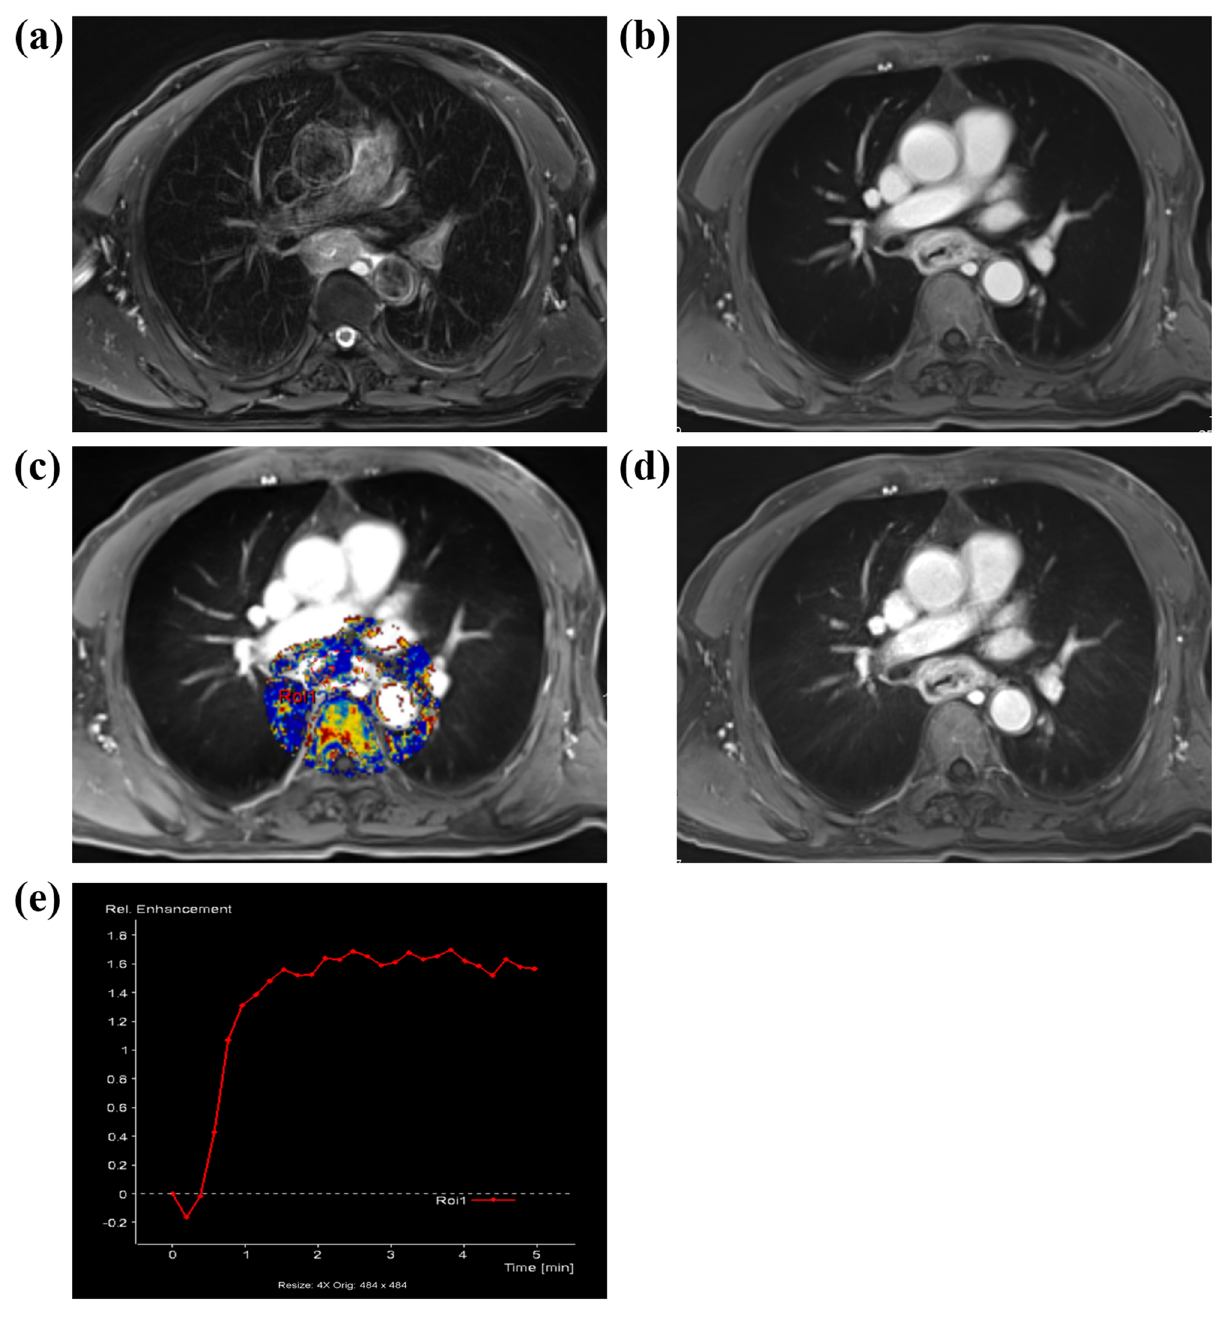
Figure 2. A patient (the age, 55–60) with esophageal carcinoma, perfusion scanning was performed with star- VIBE sequence. ( a ) The axial image of T 2 fat suppression shows thickened esophageal wall and narrowed lumen. ( b ) No respiratory artifact was demonstrated in the constructed axial image acquired with T1 fat suppression star-vibe sequence. ( c ) The pseudo-color map of Ktrans in interest regional of volume (Vol), in which ROI 1 is the lesion region. ( d ) The 14th phase image with original star-VIBE sequence data shows satisfactory inner and outer contours of the lesion, and the respiratory artifact was not obvious. ( e ) The dynamic enhancement curve of ROI 1 shows a quick rise platform characteristic, and the perfusion parameters are Ktrans 0.51 min −1 , Kep 0.89 min −1 , Ve